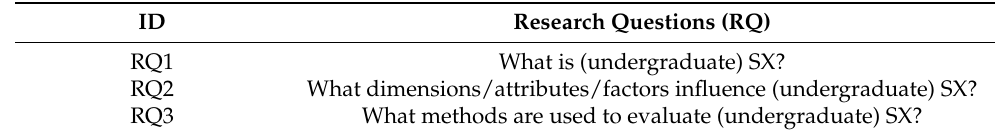
Table 1. Research questions used in the review.